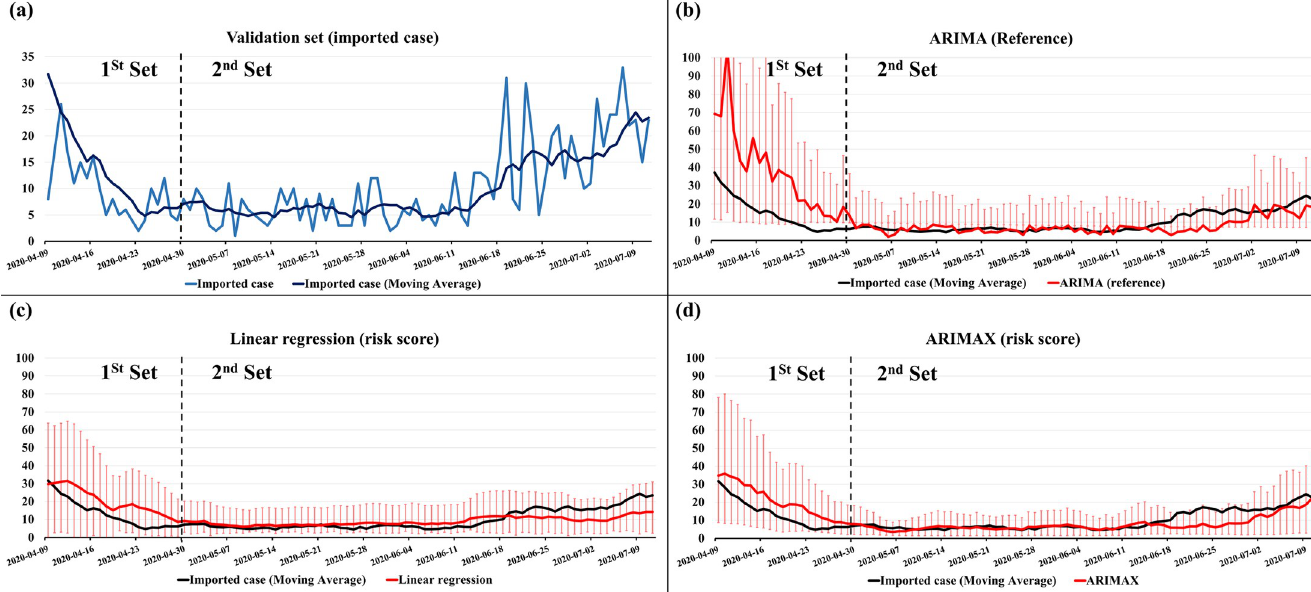
Fig 2. The forecast of imported COVID-19 cases after 12 days in South Korea. The forecast in both first and second validation sets is displayed. The black line denotes real imported cases in South Korea, the red line denotes the prediction values, and the red bars represent the 50% confidence intervals.